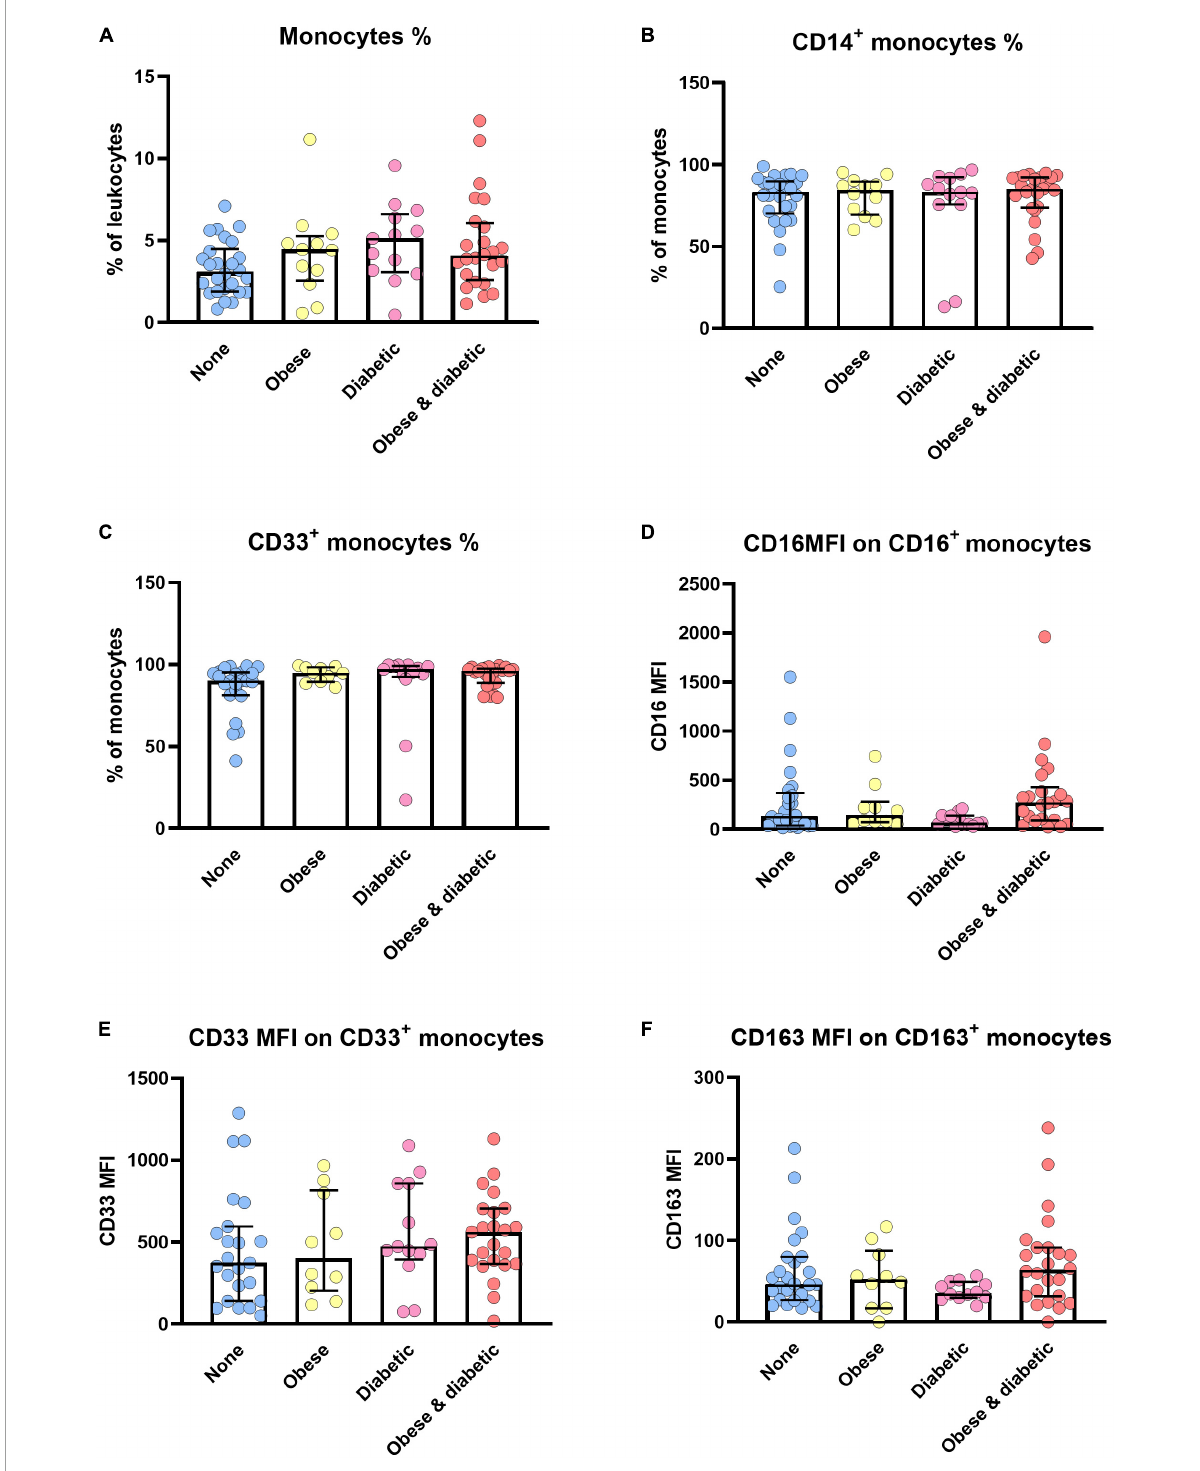
FIGURE4 Monocyte alterations in sepsis/septic shock patients with and without obesity, diabetes or both. Distribution changes in the percentage of monocytes among the total leukocyte population (A) and the percentage of CD14 + monocytes (B) and CD33 + monocytes among the monocyte population (C) . (D) Surface phenotype expression of CD16, (E) CD33 and (F) CD163 on positive monocytes determined by mean fluorescence intensity (MFI). Data are presented by scatter with bar plots. Results are medians with interquartile range. Kruskal-Wallis test were respectively used to analyze the differences among four groups. Significant difference is marked by * p <